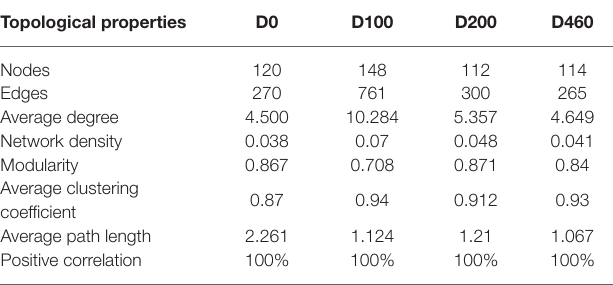
TABLE 1 | Properties of litter fungal community correlation network as decomposition progressed. Topological properties